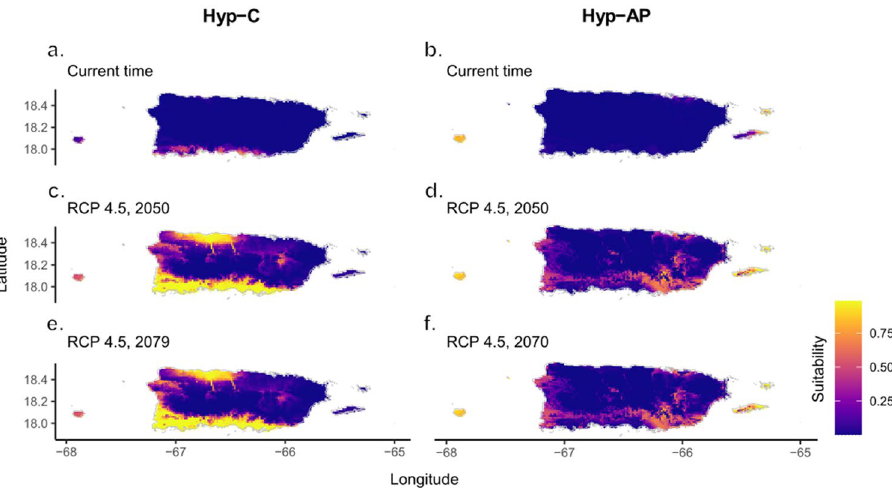
Figure 5. Ecological niche models of both Hypogeococcus species invading Puerto Rico. Maps indicate the suitability values of the best model of Hyp-C ( a ) and Hyp-AP ( b ) for the current time, future intermediate scenario (RCP 4.5) for the years 2050 (average for 2041–2060) ( c, d ) and 2070 (average for 2061–2080) ( e, f